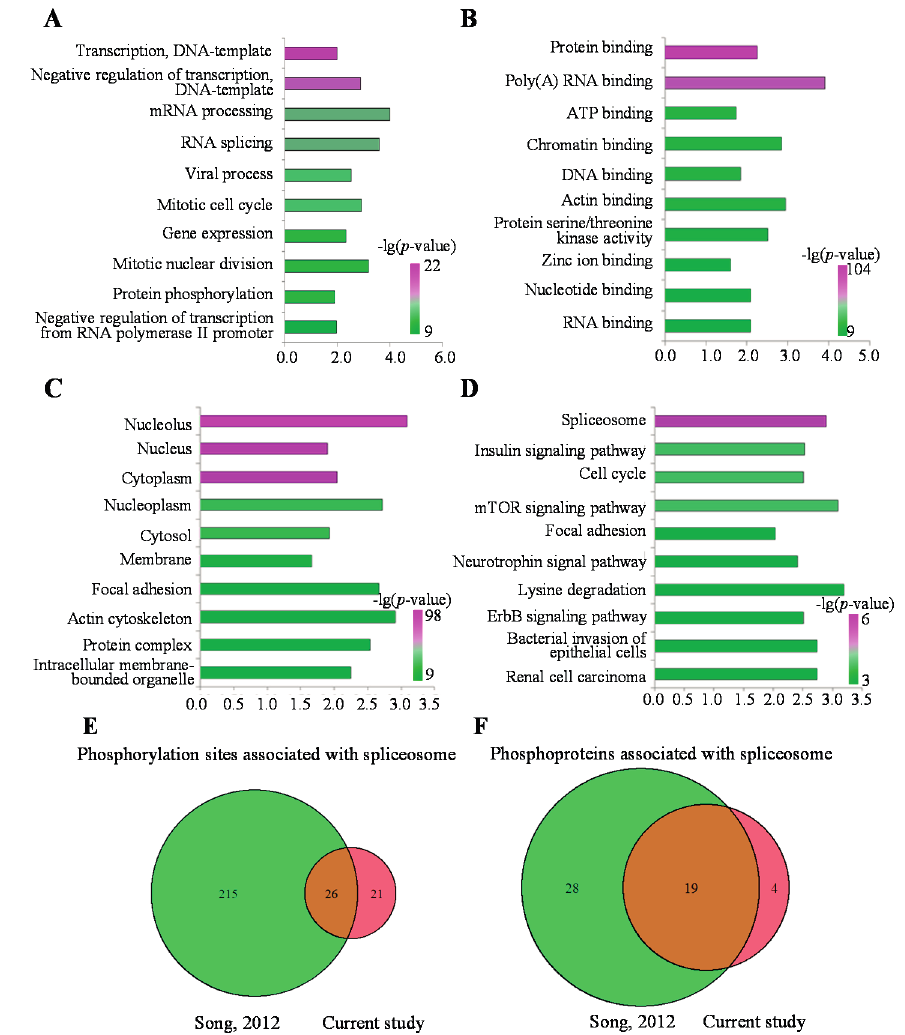
Figure 5. Gene Ontology (GO) annotation and the Kyoto Encyclopedia of Genes and Genomes (KEGG) pathway (top 10) analysis for phosphoproteins. ( A ) Biological process of GO annotation (top 10); ( B ) Molecular function of GO annotation (top 10); ( C ) Cellular component of GO annotation (top 10); ( D ) The most over-represented KEGG pathways; ( E ) Comparison of p-sites associated with the spliceosome between MHCC97-H and the normal liver sample; ( F ) Comparison of phosphoproteins associated with the spliceosome between MHCC97-H and the normal liver